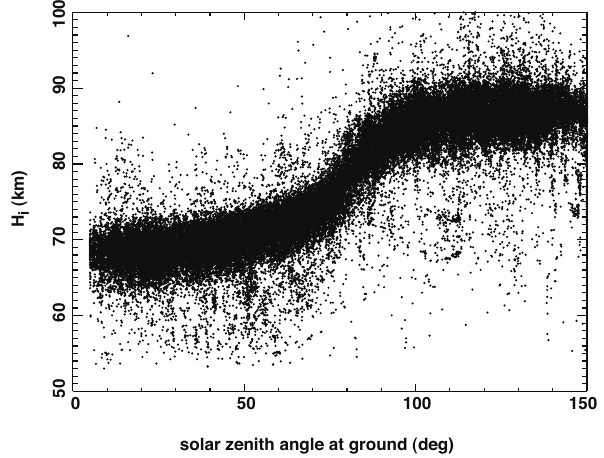
Fig. 5. Similar to Fig. 4, but for only those height retrievals from short (200–250km) range. The smooth curve is a parametric fit to the data (see